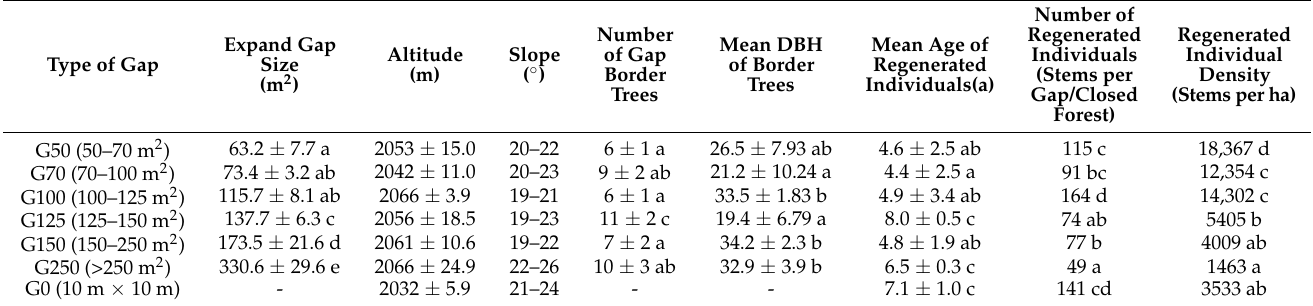
Table 1. Basic information of the L. principis-rupprechtii plantation along seven forest gap classes in the Luliang Mountains of China (n =